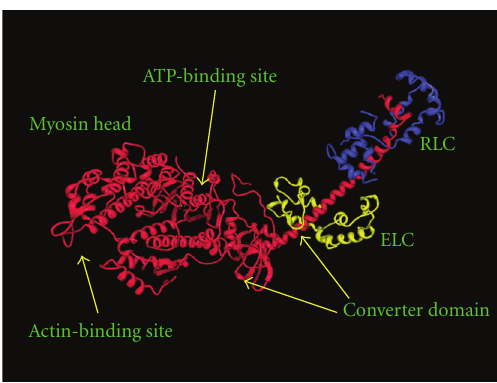
Figure 1: The structure of the myosin S1 fragment (red) with the essential (ELC) (yellow) and regulatory (RLC) (blue) light chains marked. The structure is based on the X-ray crystallographic data available in the form of the 2MYS pdb file [43].